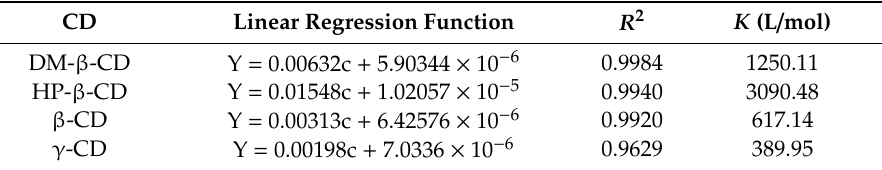
Table 1. The Linear regression equation and the stability constants for CD: myricetin inclusion complexes .